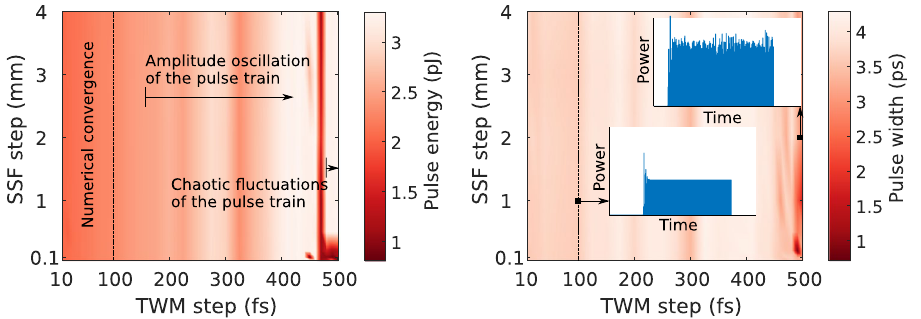
Figure 4. Stability analysis of the hybrid mode-locked laser model for an injection current of 45 mA. Map of the pulse energy (left) and of the pulsewidth (right) as a function of the discretization step of the TWM and the stepsize of the split-step Fourier